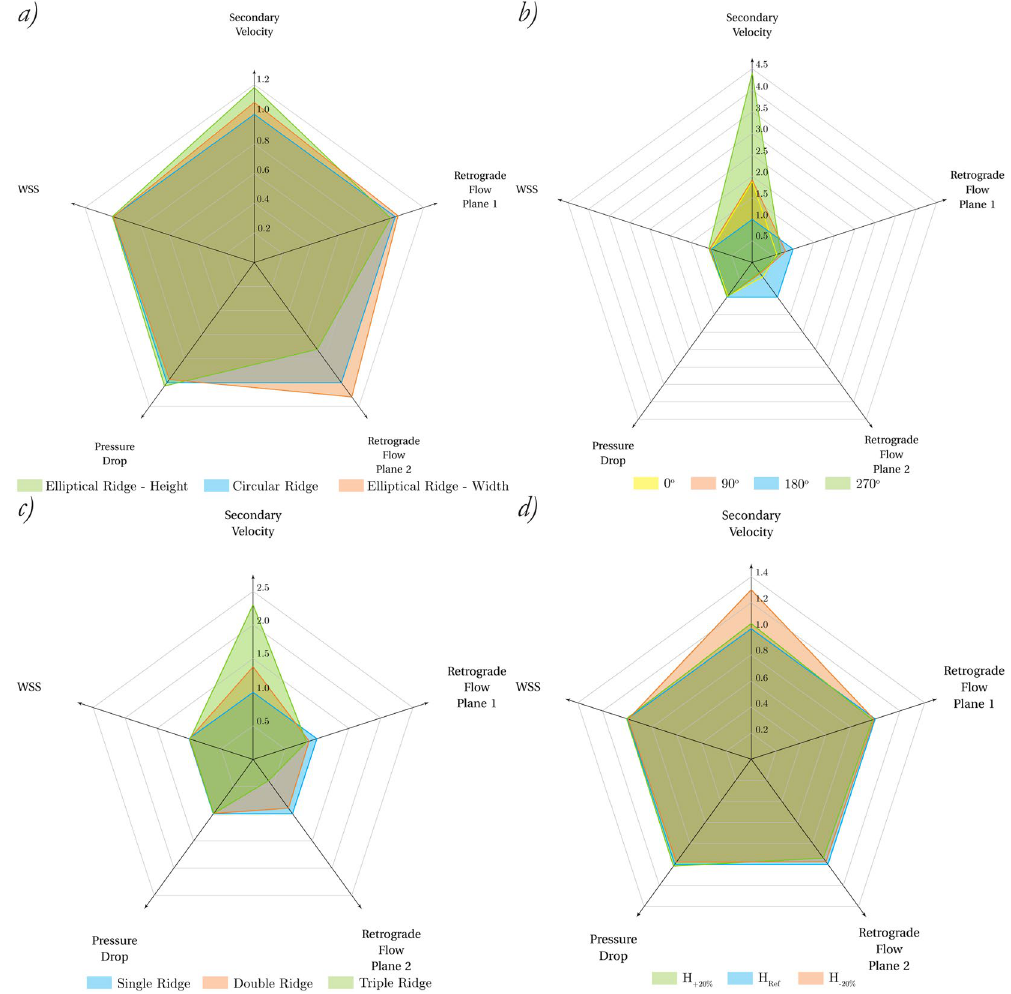
Figure 5. Overall comparison of normalised results for different ridge